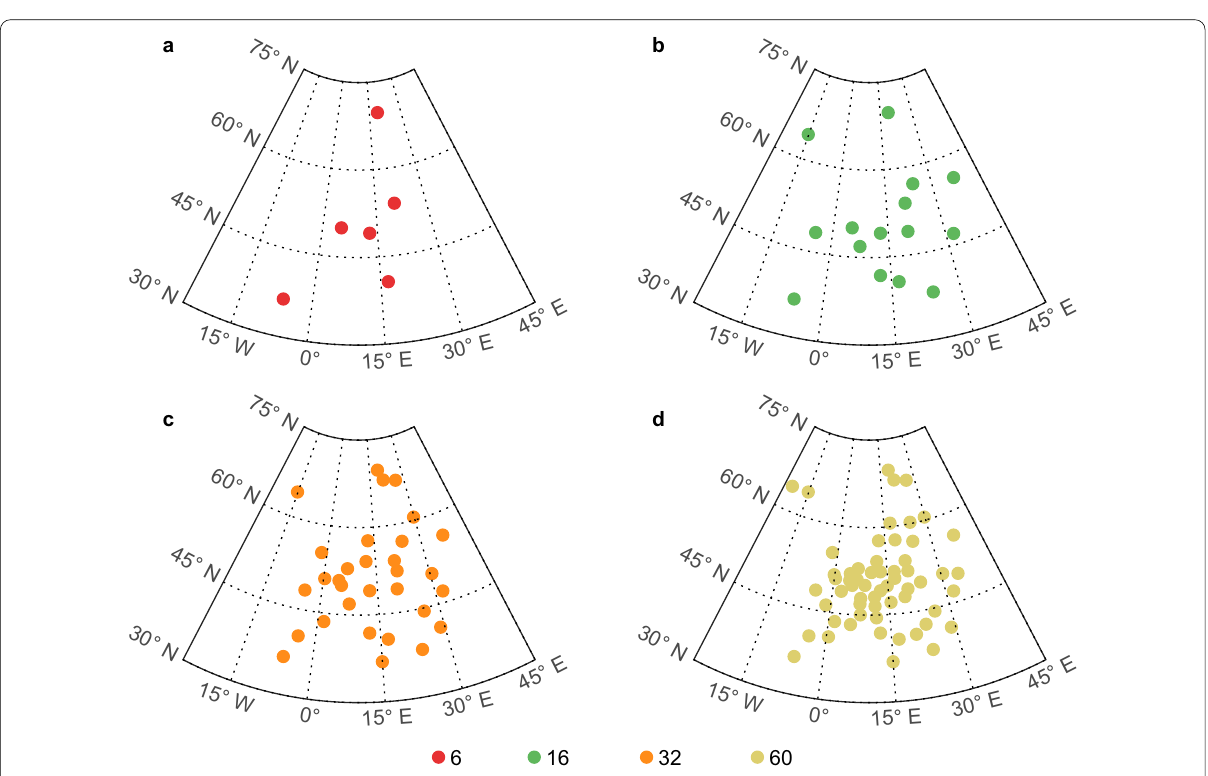
Fig. 7 Distribution of European regional networks with different number of ground stations: a 6, b 16, c 32 and d